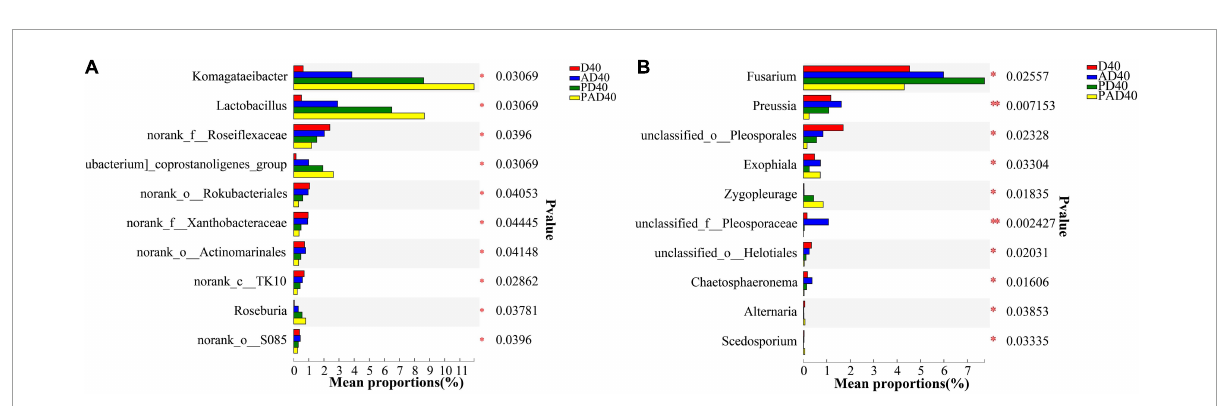
FIGURE5 Community differences of bacteria (A) and fungi (B) at the genera level caused by ABA (95% confidence interval). D40: severe desertified soil grew grass with 40 days drought; PD40: severe desertified soil grew grass with 40 days drought; AD40: severe desertified soil grew grass with 40 days drought and ABA treatment; PAD40: severe desertified soil grew grass, with 40 days drought, PAM, and ABA treatment.